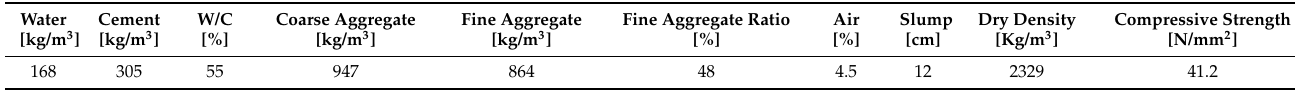
Figure 8. Overview of experiment of: ( a ) Fabricated RC test piece; ( b ) Electrolytic corrosion test. Table 3. Concrete mixing and fresh property of the concrete, and averaged mechanical property of the concrete test piece wet-cured for 28 days.